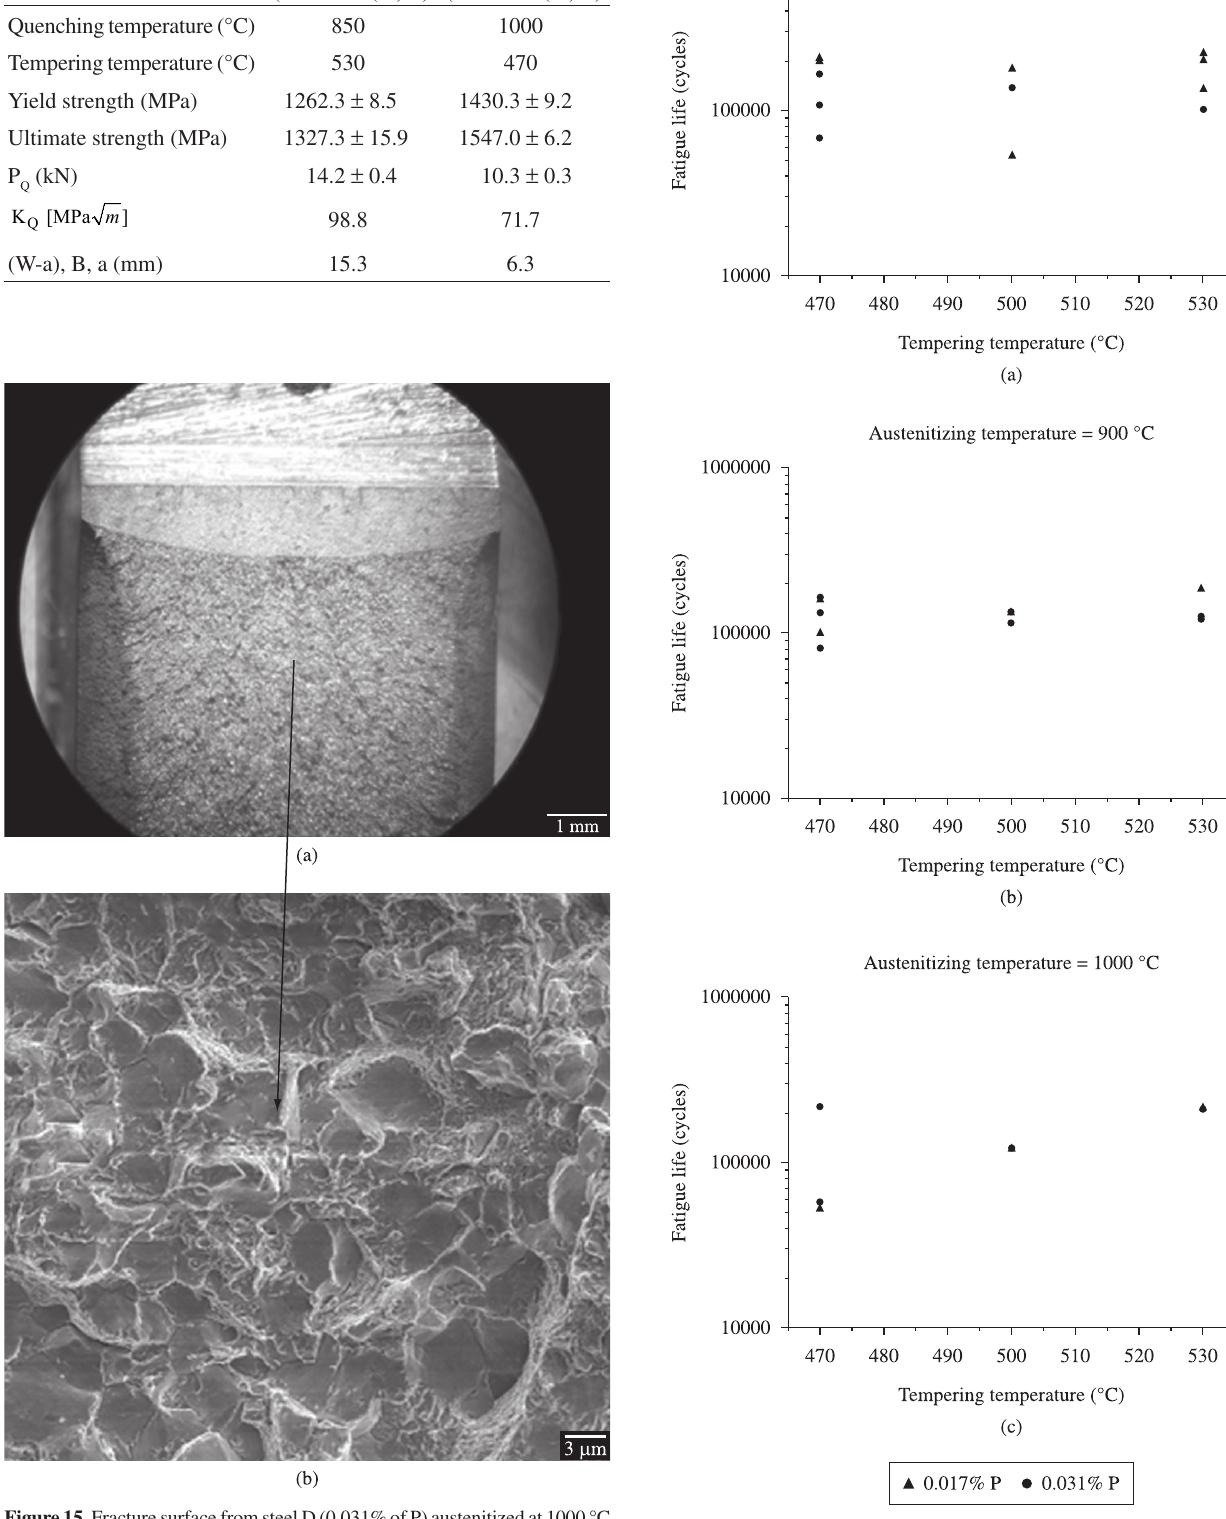
Figure 16. Fatigue test results (S-N) performed in the heat-treated samples for austenitizing temperatures of a) 850 °C; b) 900 °C; and c) 1000 °C and a σ máx = 130 MPa applied in the center of the sheet and R = 0.1.